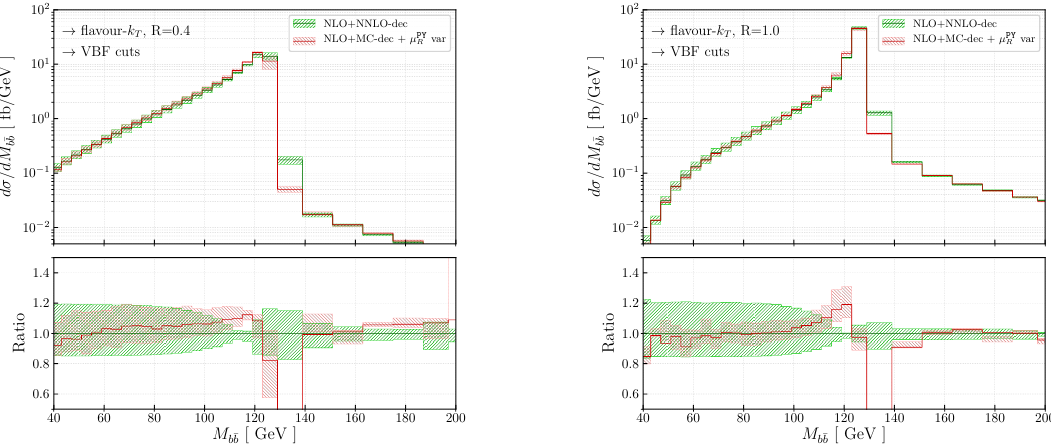
Figure 6 . Same results as in (cid:12)gure 5, but here the \NLO+MC-dec" uncertainty band contains also PS scale variation, as explained in the